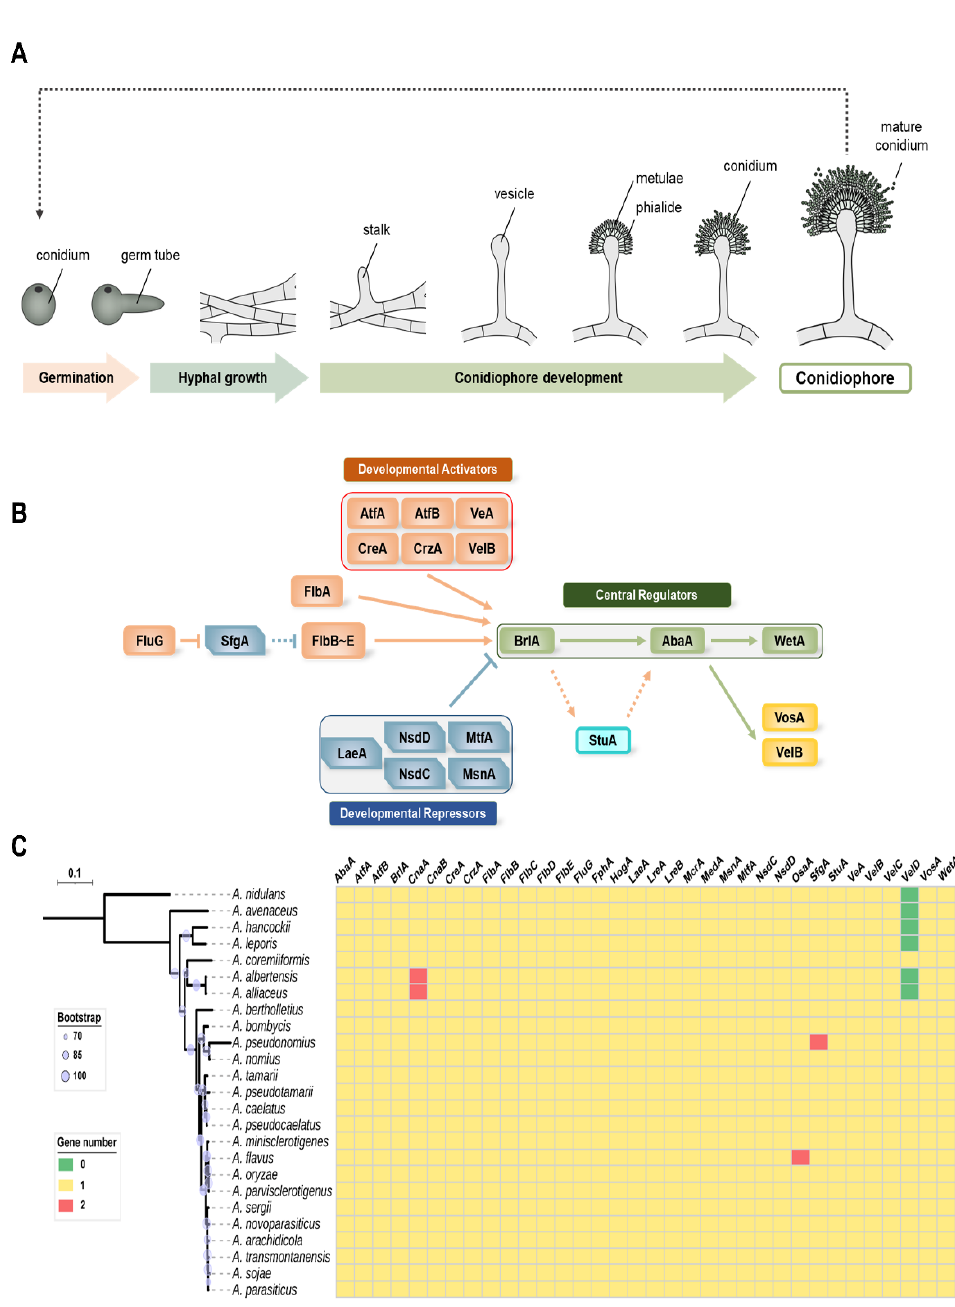
Figure 1. Asexual developmental regulators in Aspergillus spp. ( A ) A morphogenic model of conidiophore development of A. flavus . ( B ) A genetic model of the regulation of conidiogenesis in A. flavus . ( C ) Distribution of regulators involved in conidiogenesis in Aspergillus section Flavi.